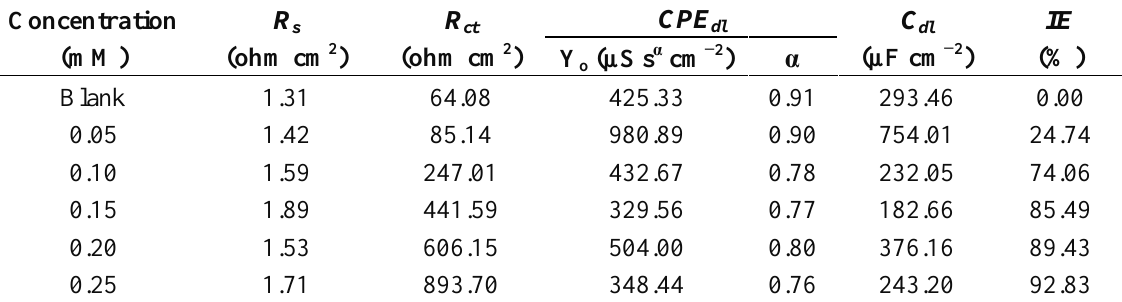
, double-layer charge; IE , inhibition efficiency ( IE dl